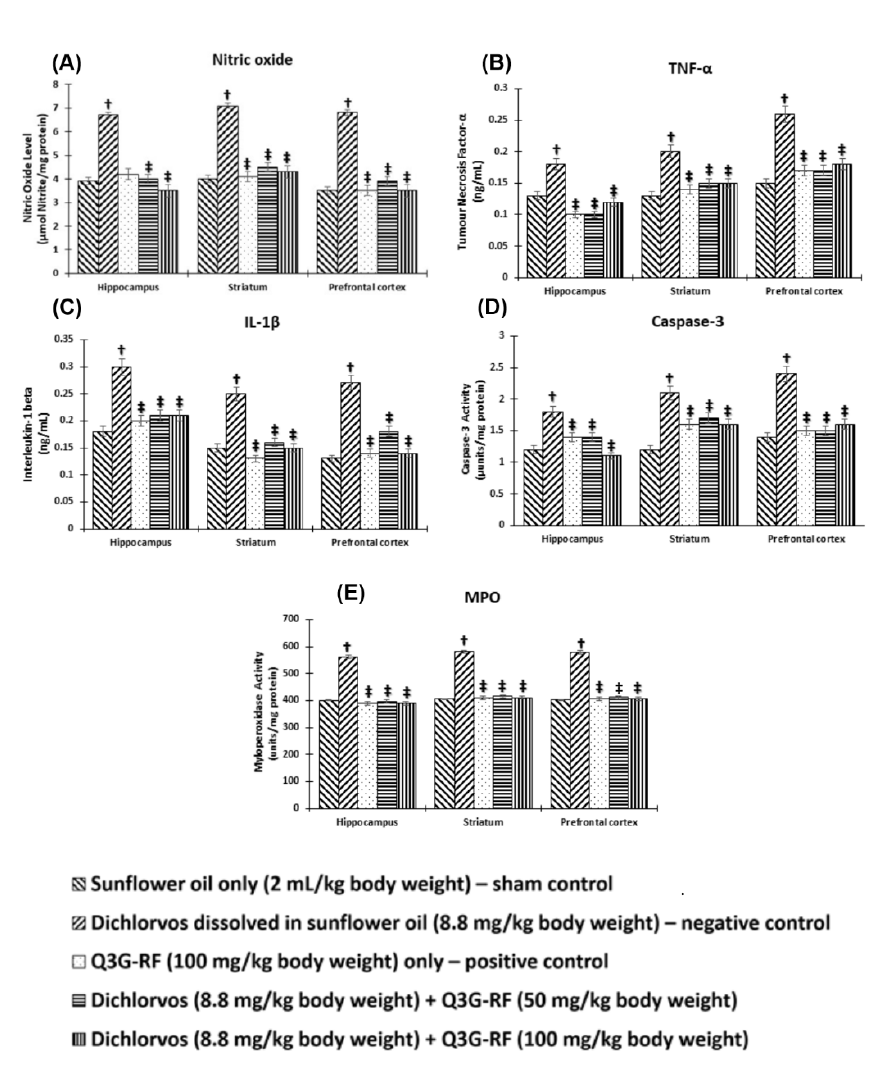
Figure 5. Effects of Q3G-RF from S. mombin leaves on inflammation and apoptotic markers in the brain of DDVP-induced neural impairment of female Wistar rats. NO ( A ), TNF- α ( B ), IL-1 β ( C ), as well as activities of caspase 3 ( D ), and MPO ( E ) of Wistar rats treated with sunflower oil, DDVP alone, Q3G-RF alone, and DDVP + Q3G-RF (50 and 100 mg/kg). Values are expressed as mean ± standard error of mean ( n = 10). Significant differences from the positive control group are indicated by † and from DDVP alone by ‡ , ( p < 0.05). DDVP, Dichlorvos; Q3G-RF, Quercetin-3-O- β -D-glucopyranoside-rich fraction from Spondias mombin .